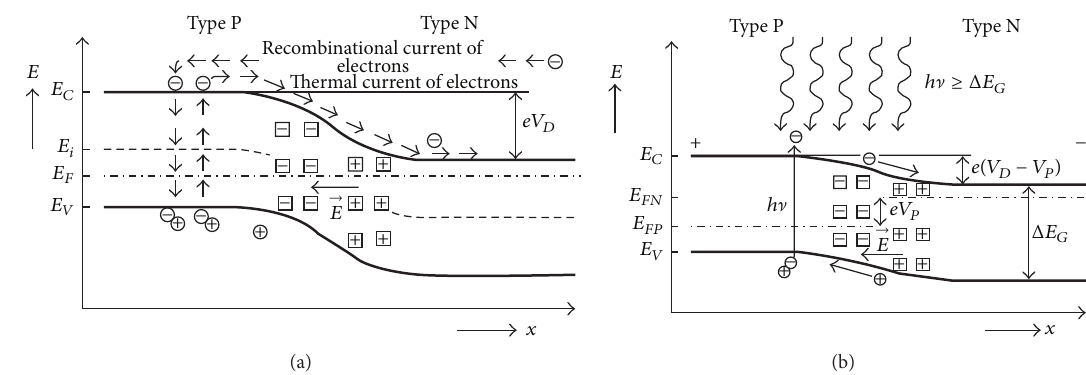
Figure 6: Band diagram of energy levels of the PN junction: (a) not illuminated, (b) illuminated ( 𝐸 𝐹 : Fermi energy level, 𝐸 𝑖 : center of the forbidden gap, 𝐸 𝑉 : valence band edge, 𝐸 𝐶 : conduction band edge, Δ𝐸 𝐺 : energy forbidden gap, 𝑉 𝐷 : diffusion voltage, 𝑉 𝑃 : photovoltaic voltage, ⃗𝐸 : electric field intensity, ] : frequency, ℎ : Planck constant, and 𝑥 : coordinate perpendicular to the PN